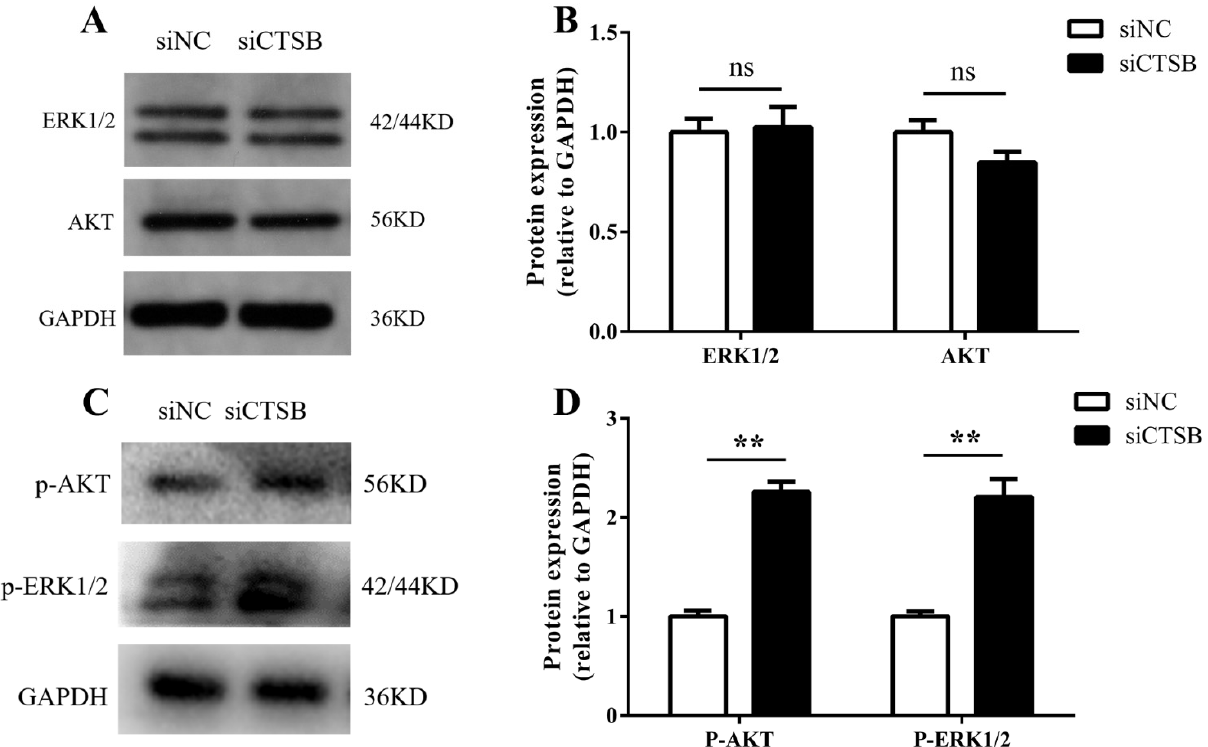
Figure 5. In vitro, CTSB downregulation activates ERK1/2 phosphorylation in mouse GCs. GCs transfected with siCTSB and siNC were harvested 48-h post-transfection for protein extracts. The level of total AKT/ERK 1/2 ( A , B ) and phosphorylated AKT/ERK 1/2 ( C , D ) proteins was quantified by Western blotting against endogenous control GAPDH . The data from three independent experiments were presented as means ± SEM, ** p < 0.01. siCTSB, cathepsin B siRNA; GCs, granulosa cells. siNC, negative control siRNA.